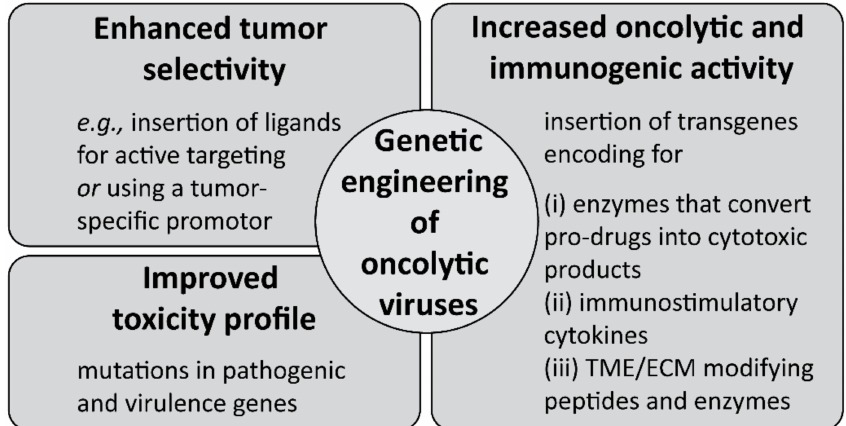
Figure 4. Genetic modifications to enhance selectivity, safety, and e ffi cacy of oncolytic virotherapies.